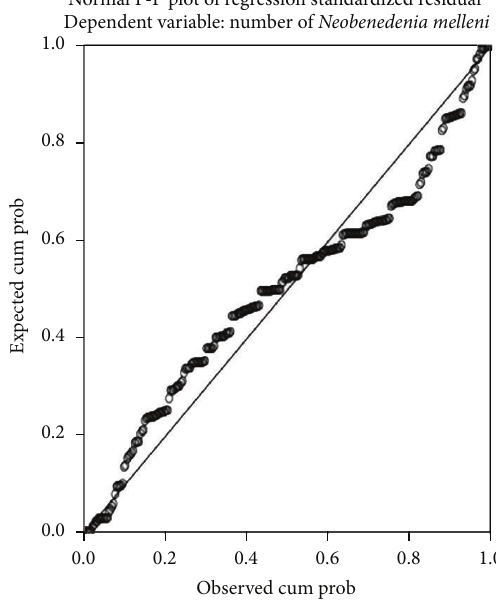
Figure 11: P-P plot shows that the points which represent the residuals lie along the diagonal line showing that the residuals are normally distributed.